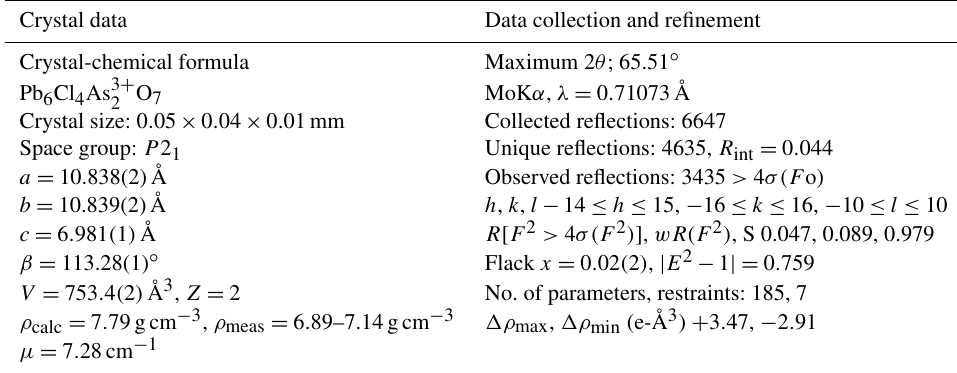
Table 2. Experimental details for heliophyllite single-crystal structural study. Crystal data Data collection and